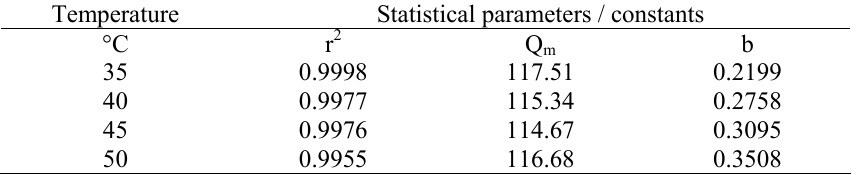
Table 3. Langmuir isotherm results for the adsorption of copper ion by CBC